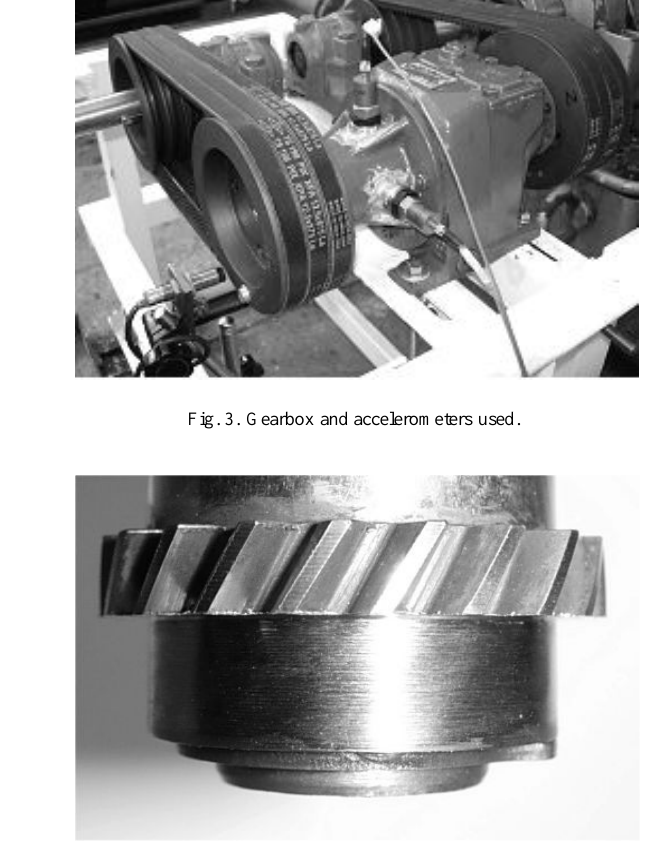
Fig. 4. Undamaged test